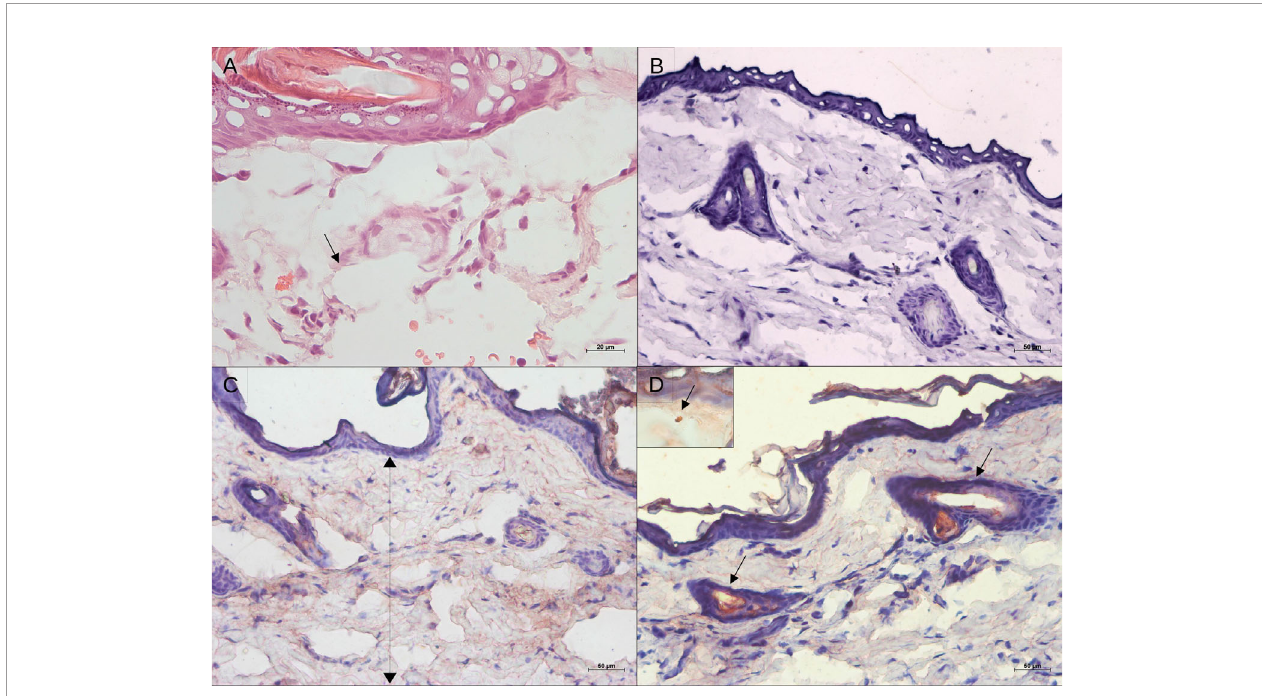
FIGURE 2 | Histological aspect and leishmanial antigen detection in the skin of golden hamsters during early after Leishmania ( Viannia ) braziliensis infection. (A) Epidermal and dermal structure at 4 hours pos-infection, showing no tissue disturbance, only intumescent lymphatic vessels (hematoxylin and eosin; 20X magni fi cation); (B) Immunohistochemistry control; (C) Immunostaining for Leishmania antigens showing antigens spread throughout the tissue at 4h, and (D) Detection of leishmanial antigens at 24 hpi showing concentrated staining of the nearest pilous follicle (50X magni fi cation). The insert displays an